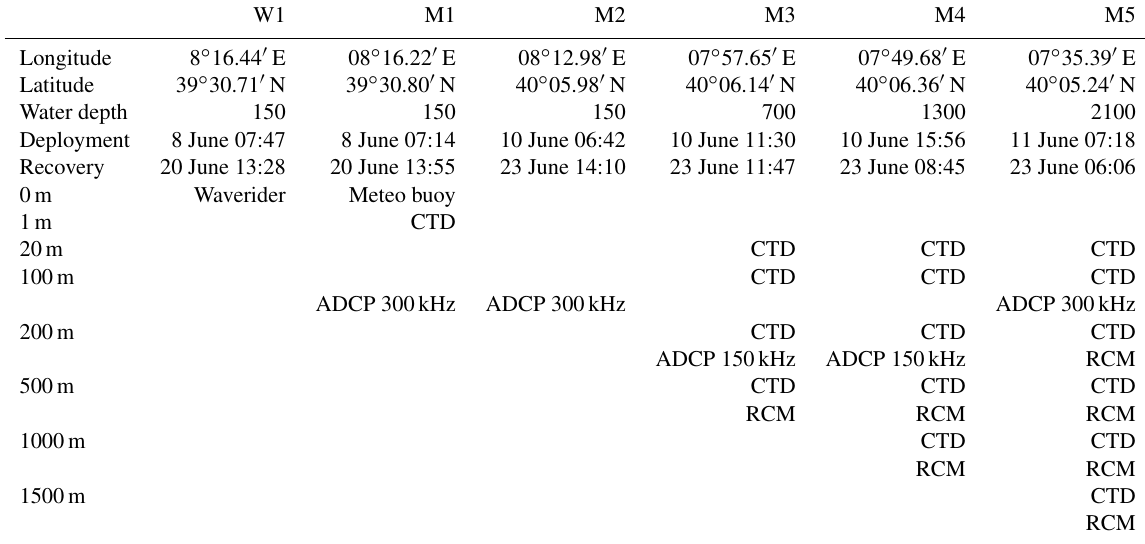
Table 4. Details of the moorings. All times are UTC. RCM stands for the Aanderaa current metres of the RCM series (http://www.aanderaa. com).